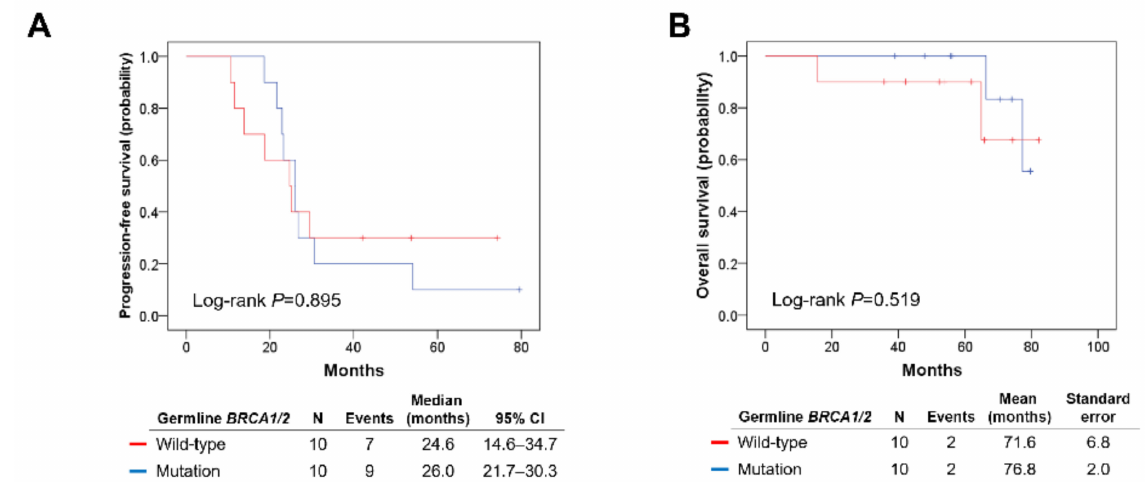
Figure 1. Comparisons of survival outcomes between germline BRCA1/2 mutation and wild-type groups. ( A ) Progression- free survival. ( B ) Overall